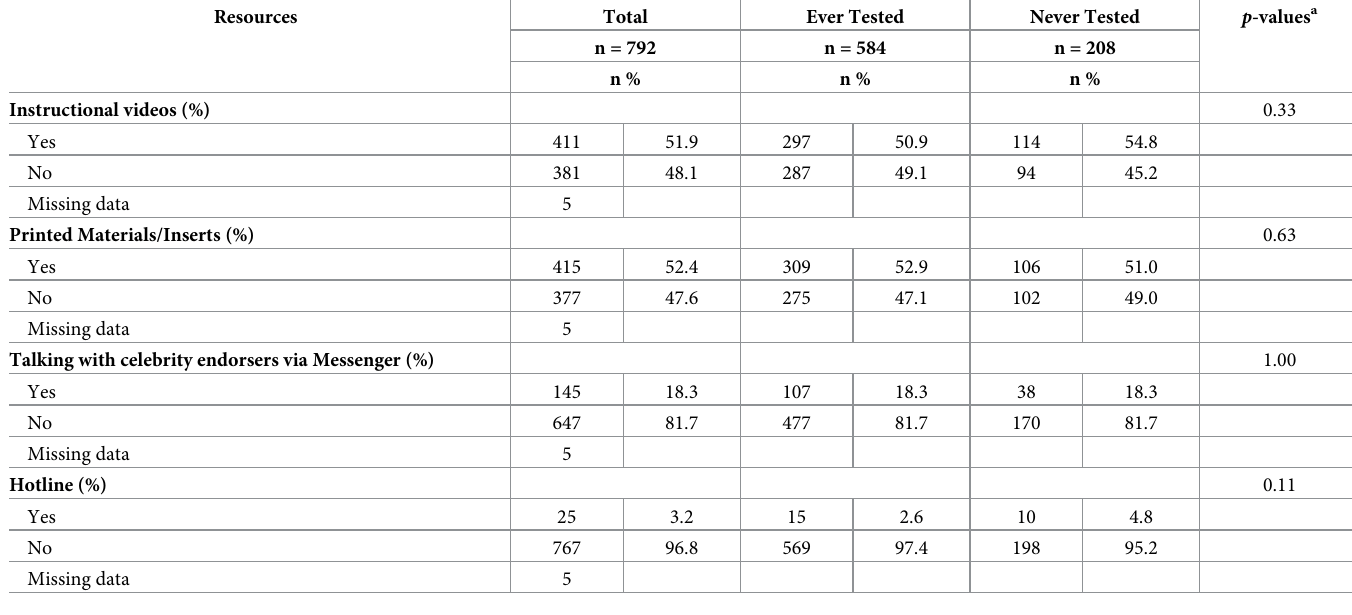
Table 3. Preference for instructional resources stratified by HIV testing experience (N = 797).